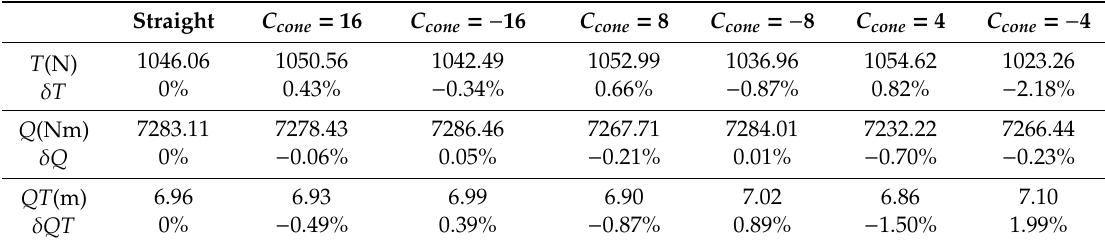
Table 5. Thrust and torque of one standard rotor and six coning configurations ( T trans = 2 / 3) at wind speed 9 m / s.